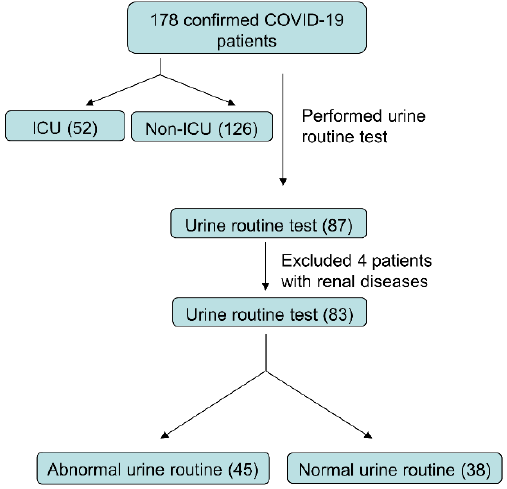
Figure 1. The flow chart of COVID-19 patients inclusion procedure .